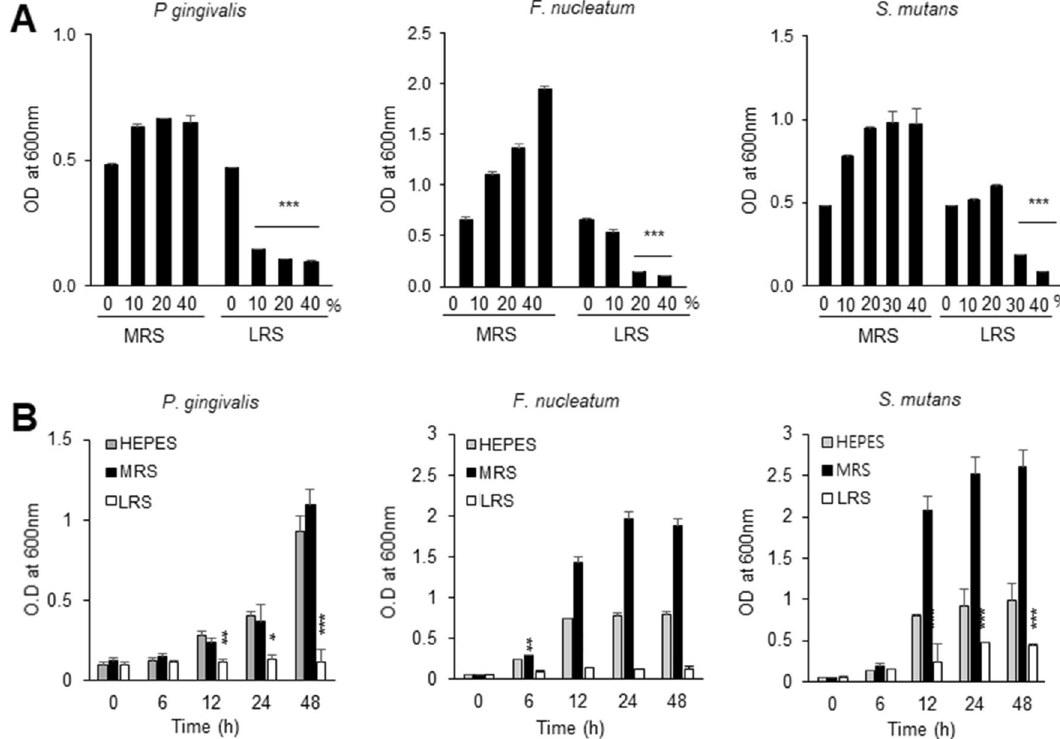
Figure 2. Effect of LRS on the growth of P. gingivalis , F. nucleatum , and S. mutans . ( A ) The effect of 0% (v/v), 10% (v/v), 20% (v/v), and 40% (v/v) LRS on the growth of pathogenic oral bacteria. Pure MRS medium was used as the control. Data presented are OD 600 values after incubation for 24 h. Significant differences from the control are indicated by (**) for p < 0.01 and (***) for p < 0.001. ( B ) The effect of 40% (v/v) LRS on the growth of pathogenic oral bacteria over time. Pure MRS medium was used as the control. Data presented are culture OD 600 values. Significant differences from the control are indicated by (*) for p < 0.05, (**) for p < 0.01, and (***) p <